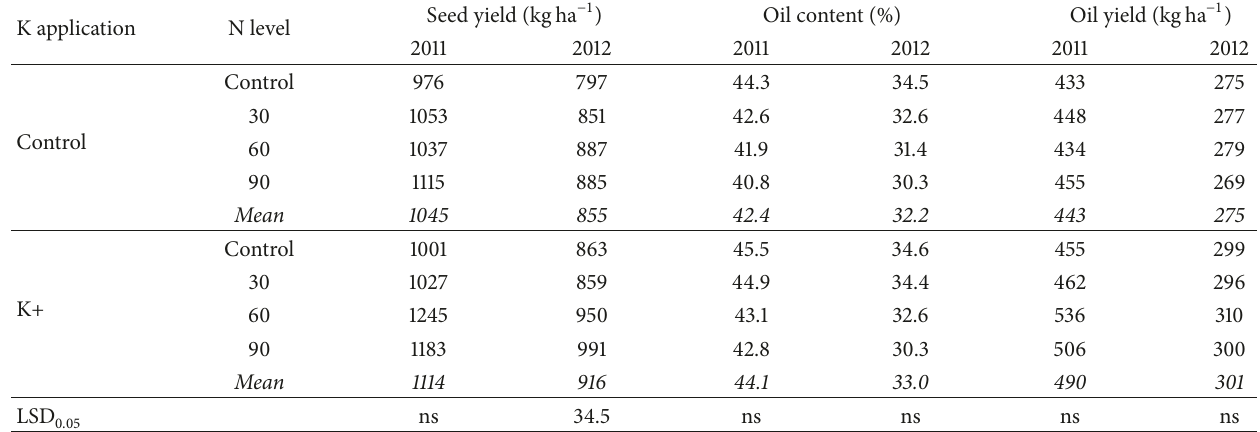
∗ and ∗∗ indicate significance at 푝 < 0.05 and 푝 < 0.01 , respectively; ns: not significant. † : means followed by the same letter(s) in each column are not significantly different at 푝 < 0.05 . Table 3: Effects of N doses and K application on seed yield, oil content, and oil yield of black cumin in 2011 and 2012. K application N